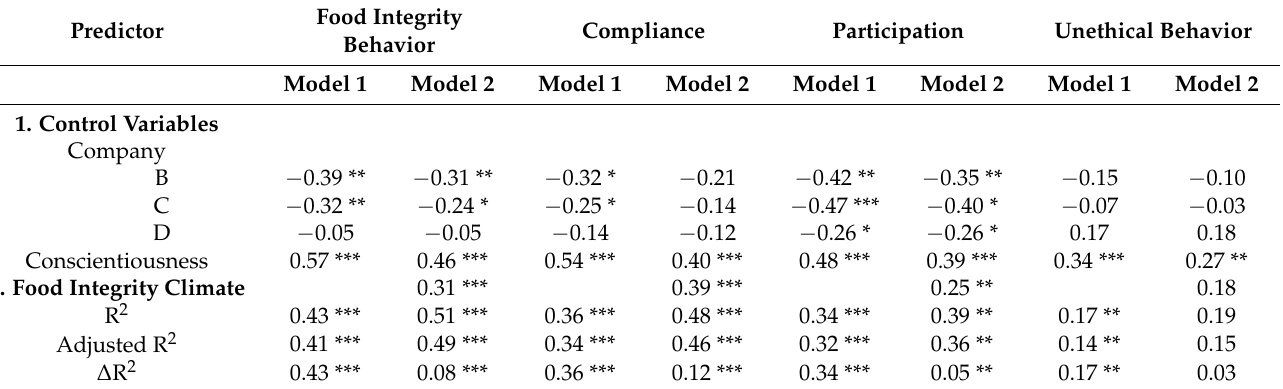
Table 3. Hierarchical linear regression of food integrity behavior and its three subscales (i.e., com- pliance, participation and unethical behavior) on control variables and food integrity climate ( n = 118 participants). Standardized regression coefficients for the respective regression steps